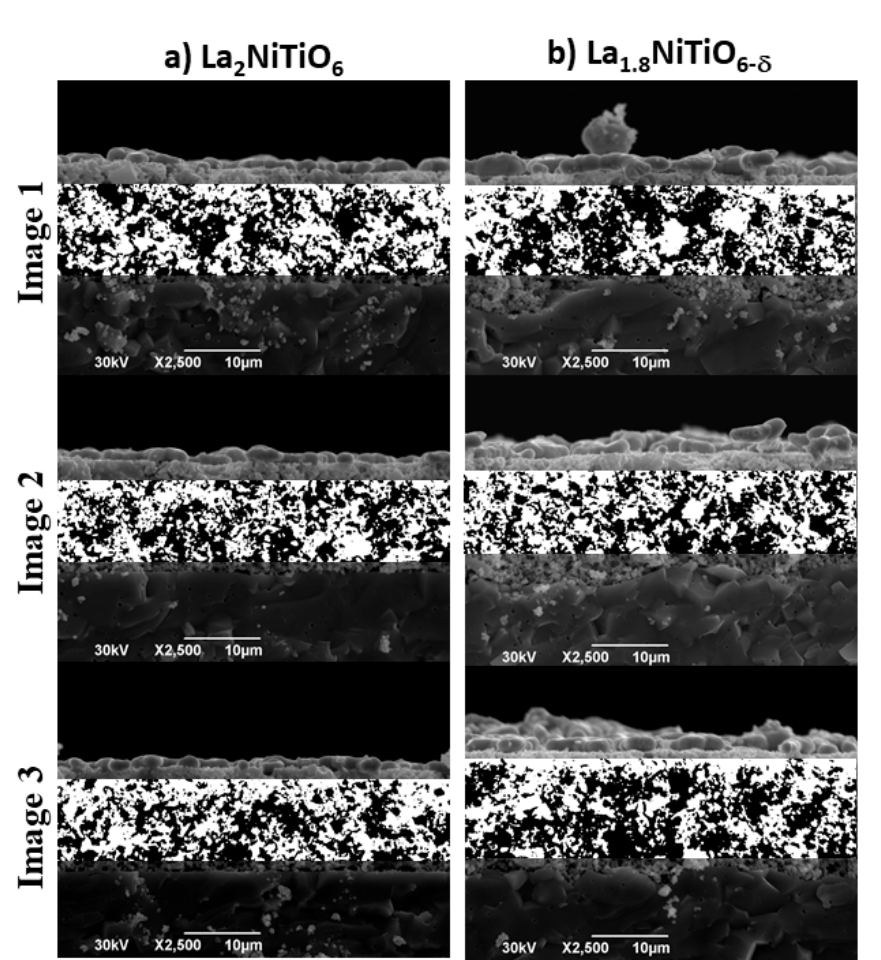
Figure 8. SEM micrographs of La 2 − x NiTiO 6 − δ :YSZ composite electrodes for ( a ) La 2 NiTiO 6 − δ and ( b ) La 1.8 NiTiO 6 −δ and segmentation by Otsu thresholding (white and black for foreground and background, respectively).